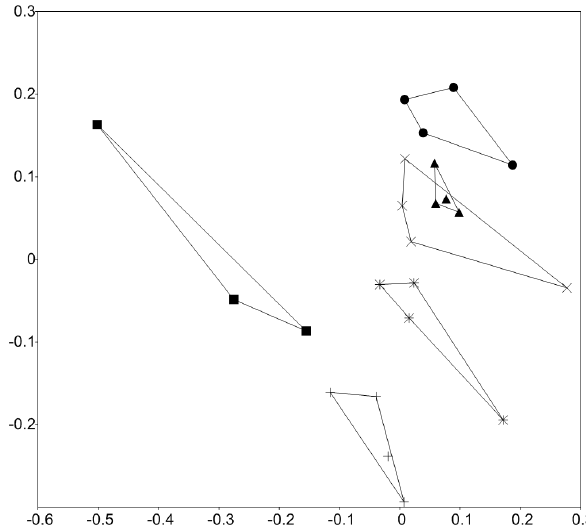
Figure 3. Non-metric multidimensional scaling ordination of N microbial communities sampled from 5000–6000 m altitudinal ) 6000 m, ( m ) 5800 m, ( 6 ) 5600 m, ( * ) 5400 m, ( + ) 5200 m, gradient. ( ( & ) 5000 m. Horizontal transect formed significant groups (NP- MANOVA, p , 0.05). Filled symbols denote barren soils. Individual samples connected by lines define convex hull surface area of NM- MDS scores of microbial community characteristics as a measure of community-space covered.